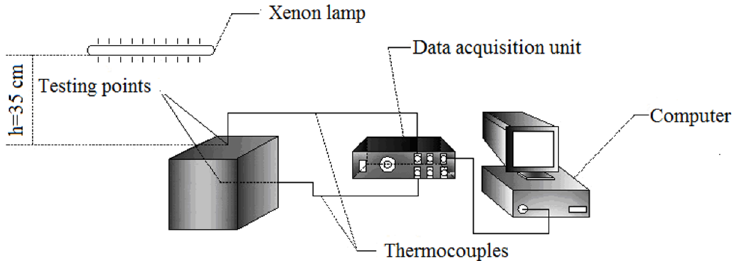
Figure 1. An experimental schematic drawing for testing energy conservation performance of composite boards.